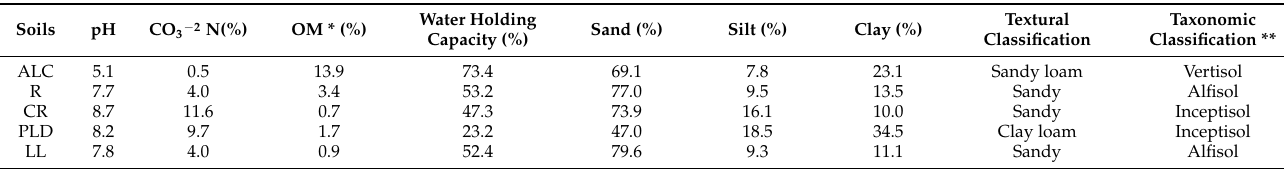
Table 1. Some properties of the soils